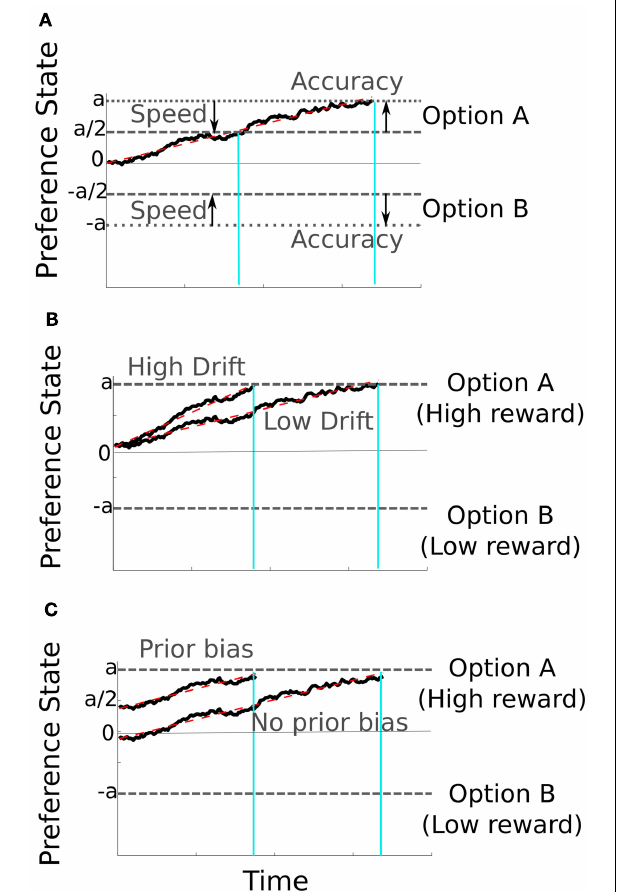
FIGURE 2 | Representative activation trajectories from the diffusion model with noise (black traces) and without noise (dashed red traces). Decision bounds are signaled by the dashed line marked with lowercase letter a or − a). In part (A) , the speed-accuracy trade-off is determined by the height of the response boundary with lower boundaries resulting in faster and less accurate decisions (and vice versa for higher boundaries). (B,C) Choice can be biased by the presence of asymmetric rewards.This is achieved either by increasing the rate of evidence accumulation (high drift trajectory in (B) for the high-reward option or by increasing its initial activation, prior to the onset of accumulation (C) .Vertical cyan lines show RTs for representative trials under conditions where speed or accuracy are emphasized (A) or where decisions are biased by reward (B,C)